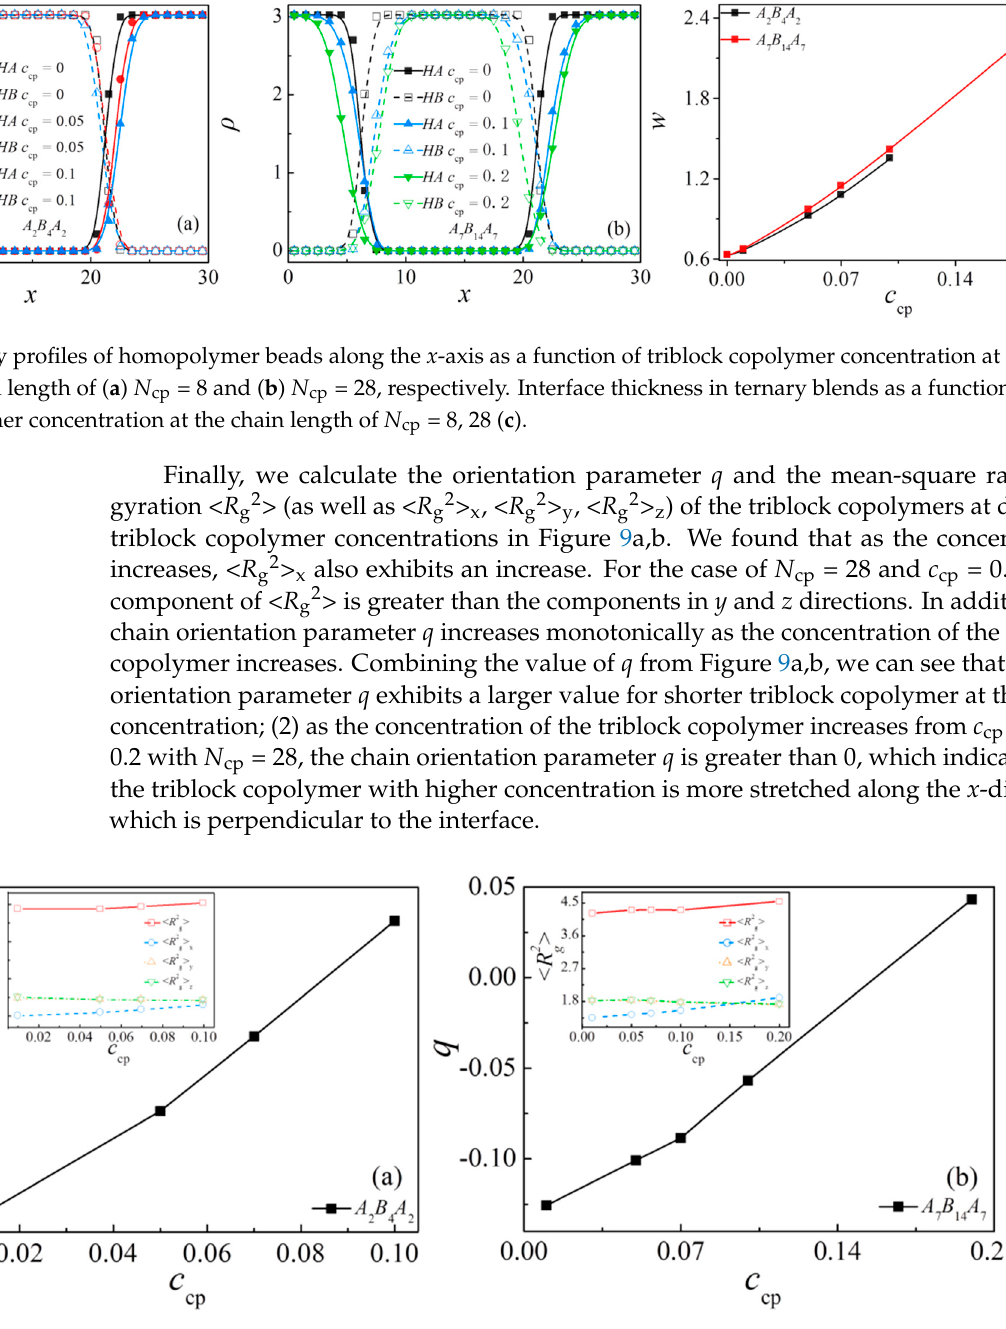
Figure 9. Orientation parameter of the triblock copolymers as a function of their chain length N cp . The inset indicates the mean-squared radii of gyration < R g 2 > and the three principal components ( < R g 2 > x , < R g 2 > y and < R g 2 > z ) of < R g 2 > . ( a ) N cp = 8 and ( b ) N cp = 28, respectively.